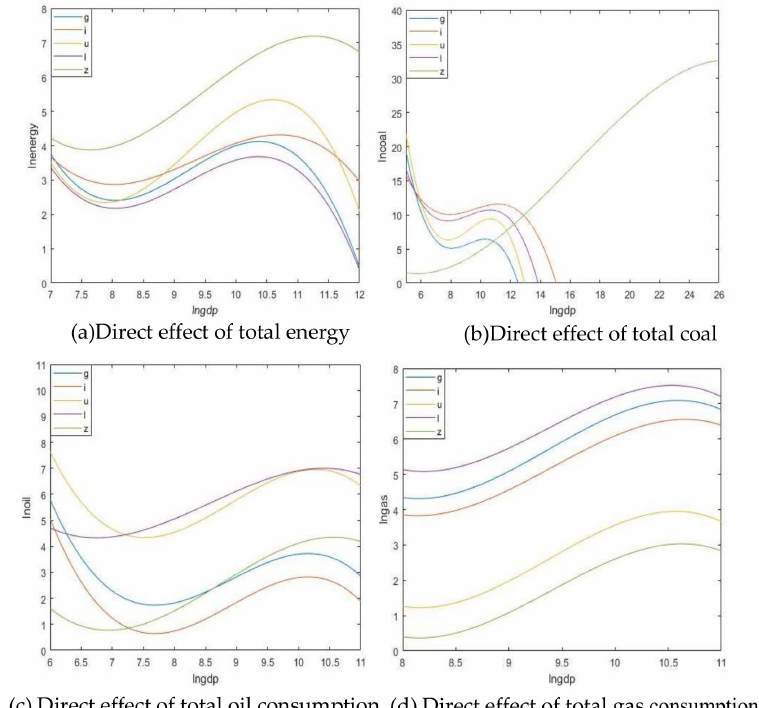
Figure 3. EKC fitting diagram of direct e ff